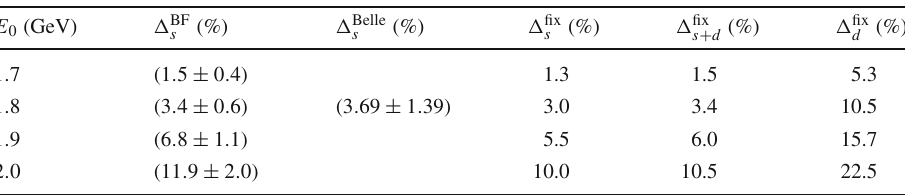
Table 1 Quantities (cid:13) q from Eq. (7) evaluated using various